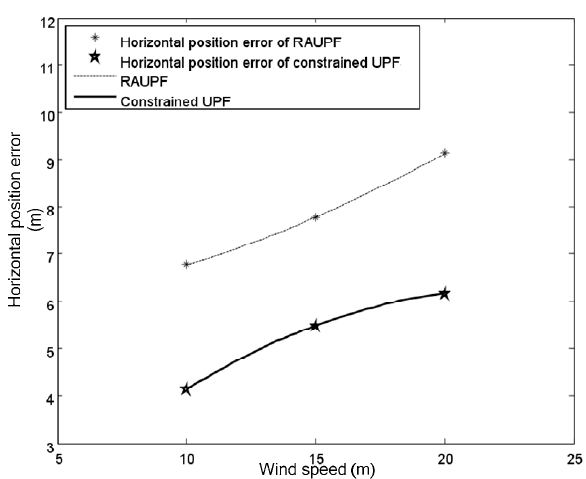
Figure 9. Horizontal velocity errors for both RAUPF and constrained UPF.